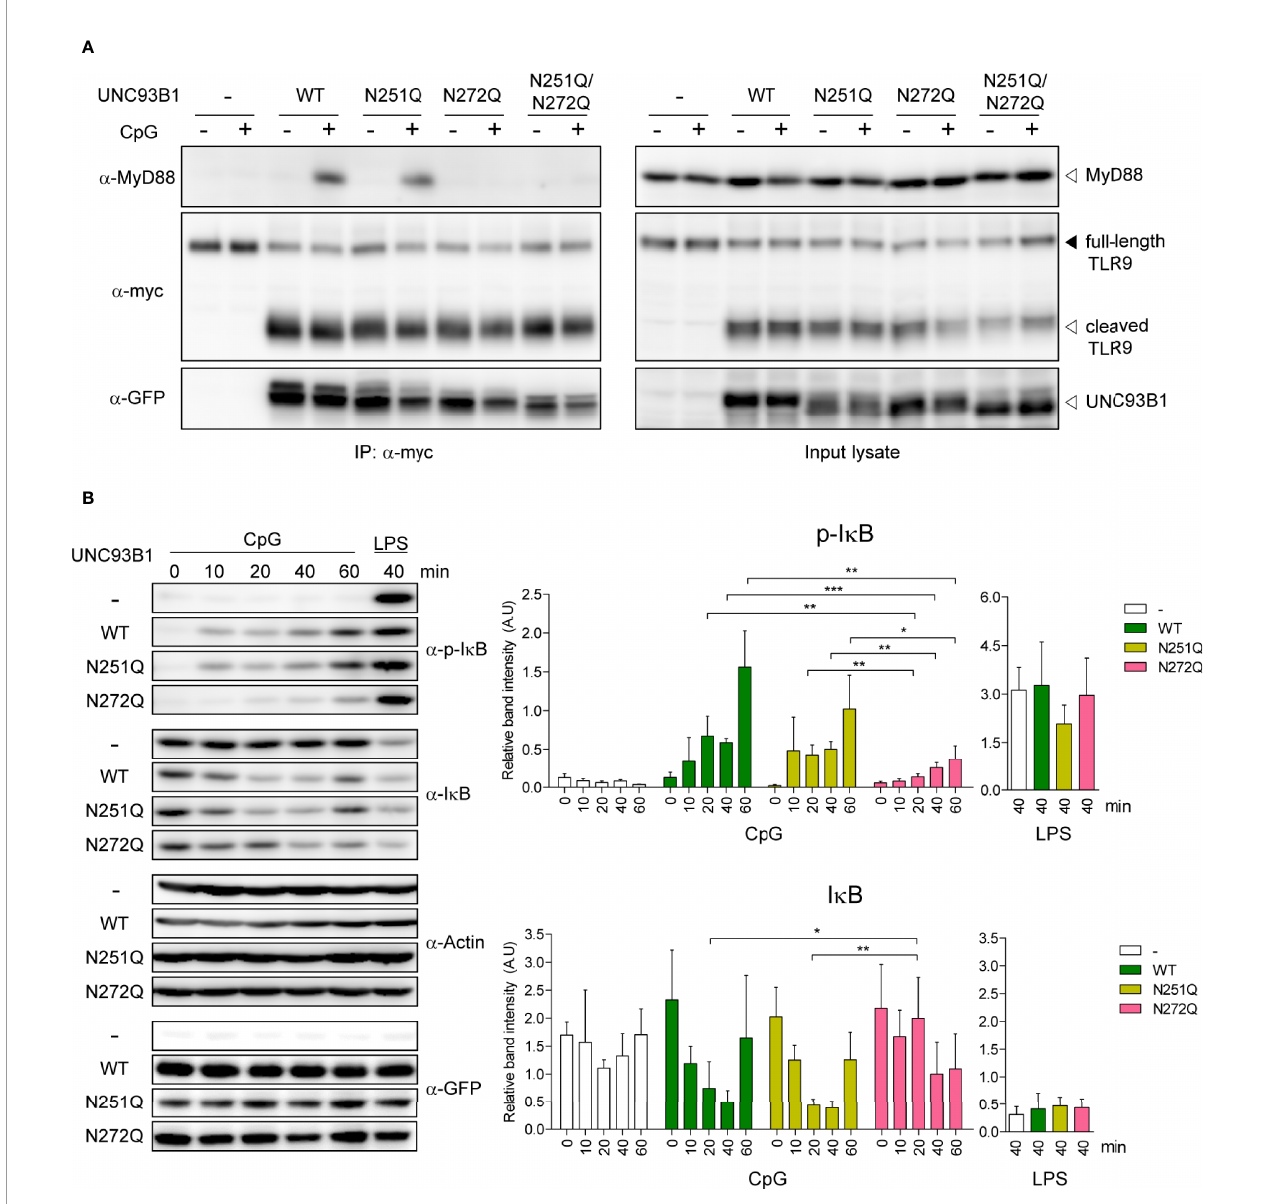
FIGURE 8 | N-glycosylation of UNC93B1 at N272 is required for MyD88 recruitment and downstream signaling of TLR9. (A) UNC93B1-GFP (wild type or mutant) and TLR9-myc were expressed in UNC93B1 KO iBMDMs. After stimulation with 1 m M CpG DNA for 2 h, cells were lysed and TLR9-myc was immunoprecipitated from the cell lysates. TLR9, UNC93B1, and MyD88 were detected from the immunoprecipitates (left panels) and the input lysates (right panel) with anti-myc, anti-GFP, and anti- MyD88 antibody, respectively. (B) UNC93B1 KO iBMDMs expressing UNC93B1-GFP (wild type or mutant) and TLR9-myc were stimulated with 1 m M CpG DNA or 100 ng/ml LPS for indicated time periods. After cell lysis, phosphorylated I k B, total I k B, actin, and UNC93B-GFP were detected by immunoblotting with anti-phospho-I k B, anti-I k B, anti-actin, and anti-GFP antibody, respectively. Representative immunoblot images from four independent experiments were shown (left panels). Relative band intensity of phosphorylated I k B (upper right panel) and I k B (lower right panel) was calculated by dividing the band intensity of phosphorylated I k B and I k B with that of actin, respectively. Data are means ± SD (n = 4). *P < 0.05, ** < 0.01, ***P < 0.001 (Student's